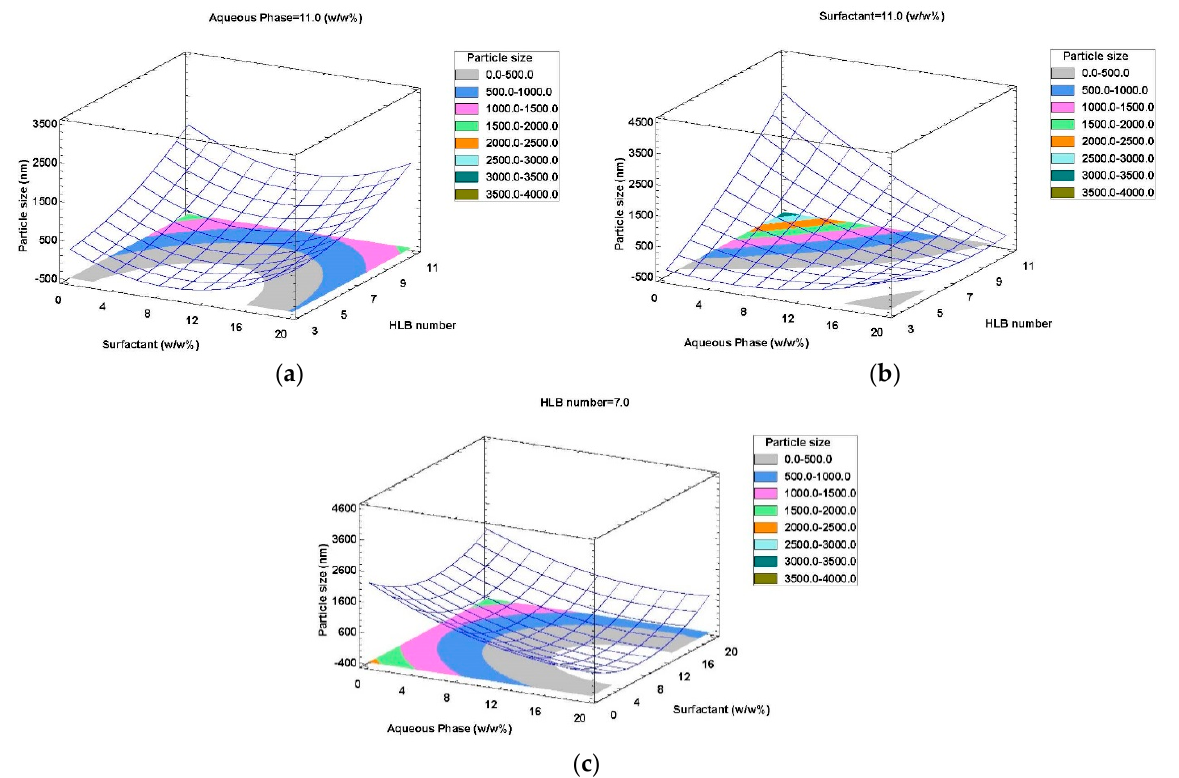
Figure 1. RSM plots of the effects of factors on particle size of W/O emulsions. ( a ) Interaction of surfactant content and HLB number; ( b ) interaction of aqueous phase content and HLB number; ( c ) interaction of surfactant and aqueous phase contents.